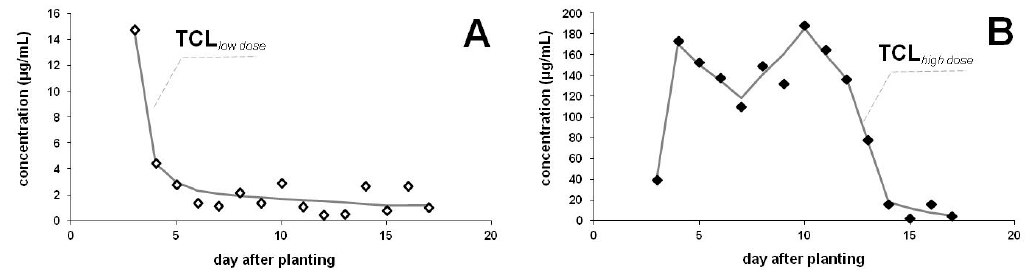
Figure 3. Neonicotinoid (TCL) occurrence from the seed coating in a commercial maize variety (LG 30.369) coated with different neonicotinoid dosages ( A : ◊ low dose, B : ♦ high dose) cultivated under semi-field conditions (sown in August). Concentration of TCL (µg/mL) in the guttation liquid of maize as a function of time after sowing.